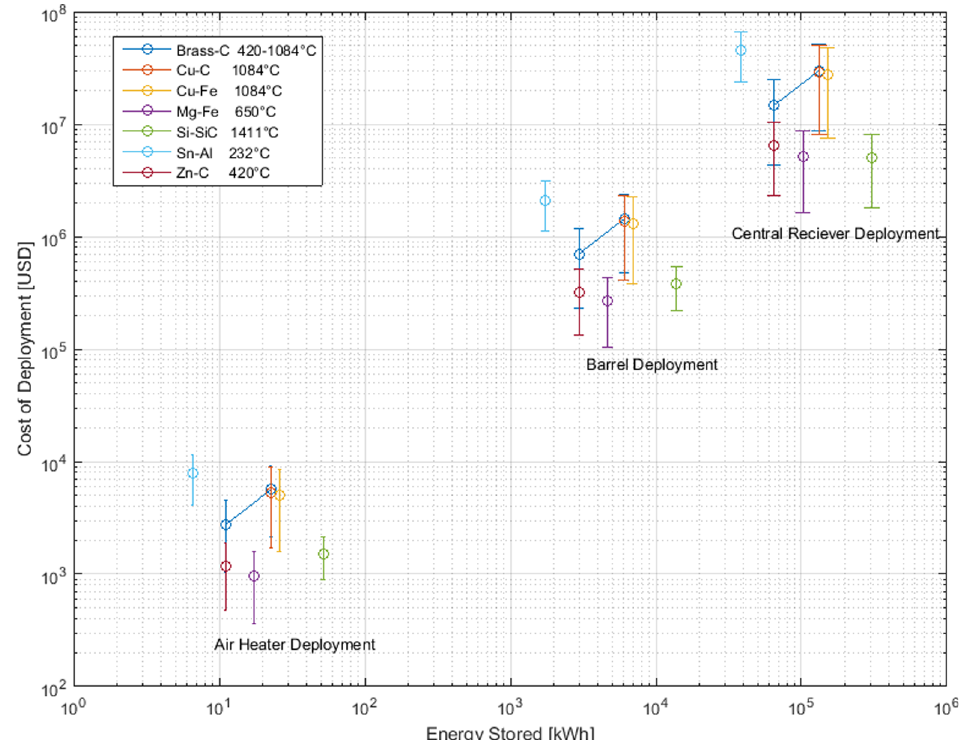
Fig. 1. Total estimated cost of deployment plotted against stored energy for seven different miscibility gap alloys in three different